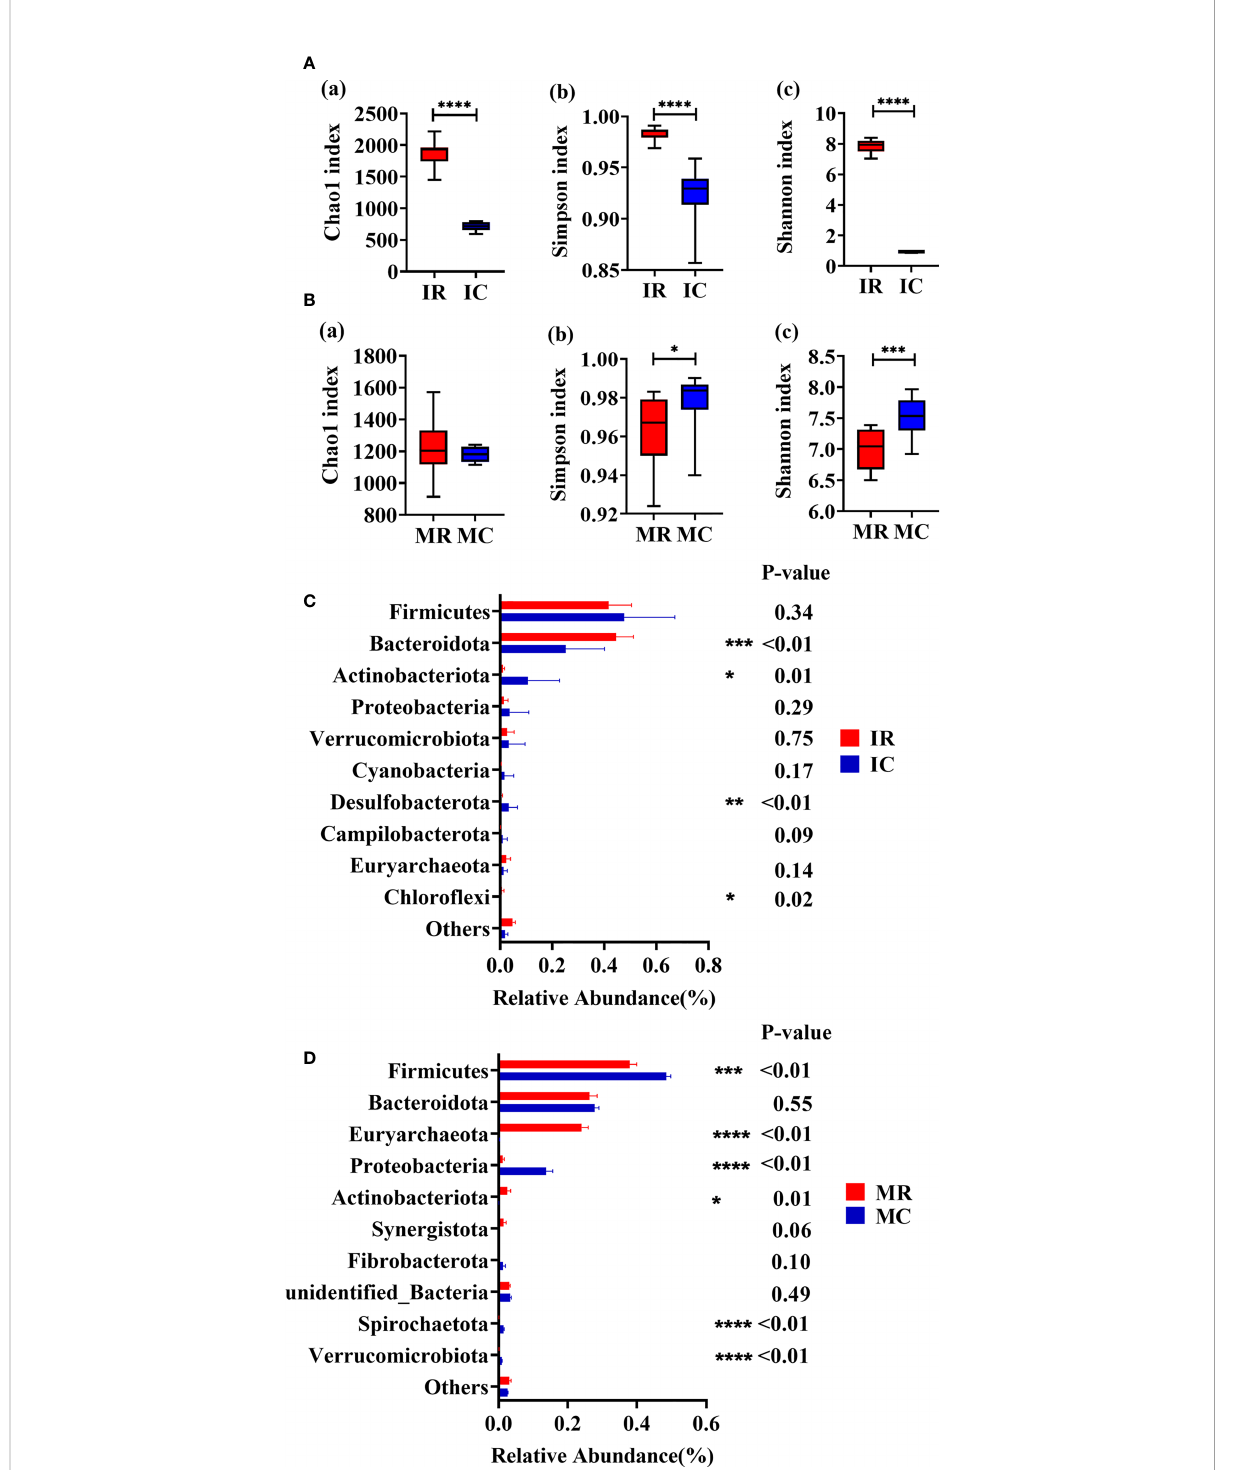
FIGURE 4 Rumen-feces microbial composition fl uctuates with age. (A) Alpha diversity of young (Chao1 index; Simpson index; Shannon index). (B) Alpha diversity of adult (Chao1 index; Simpson index; Shannon index). (C) Relative abundance of top10 phyla of young. (D) Relative abundance of top10 phyla of adult. MC: feces of adult goats. IC: feces of young goats. MR: rumen of adult goats. IR: rumen of young goats. The data were analyzed with unpaired t tests, and the data were expressed as mean ± SEM. *P < 0.05 , ** P < 0.01, *** P < 0.001, **** P <